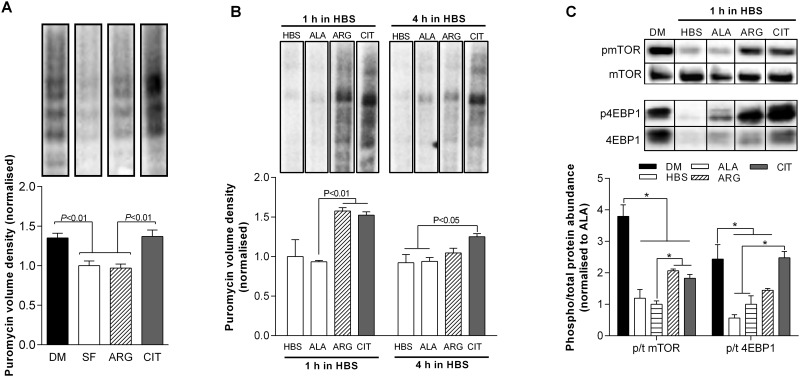
L-citrulline protects muscle cells through a preservation of protein synthesis.Protein synthesis as assessed using puromycin after 48 h in serum free (SF) media (A); and after incubation in HEPES buffered saline (HBS) for 1 and 4 h (B). Phosphorylation status (phospho/total protein) for mTOR and 4EBP1 after incubation in HBS for 1 h. Cells were treated with vehicle, 2.5 mM L-alanine (ALA), 2.5 mM L-arginine (ARG) or 2.5 mM L-citrulline (CIT). Values are means ± SE, n = 4–6 per group. Comparisons were made using a one-way ANOVA with Tukey’s post hoc test. Significant differences are indicated where appropriate. For each protein, all blots were performed on the same membrane.